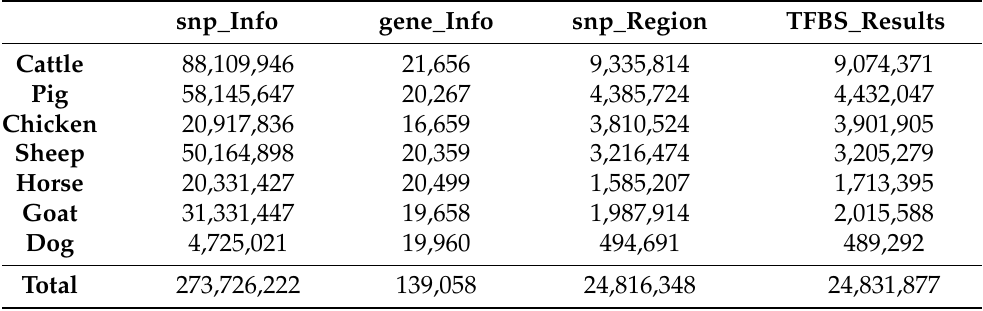
Table 3. The number of records stored in the database tables snp_info , gene_info , snp_region , and TFBS_results